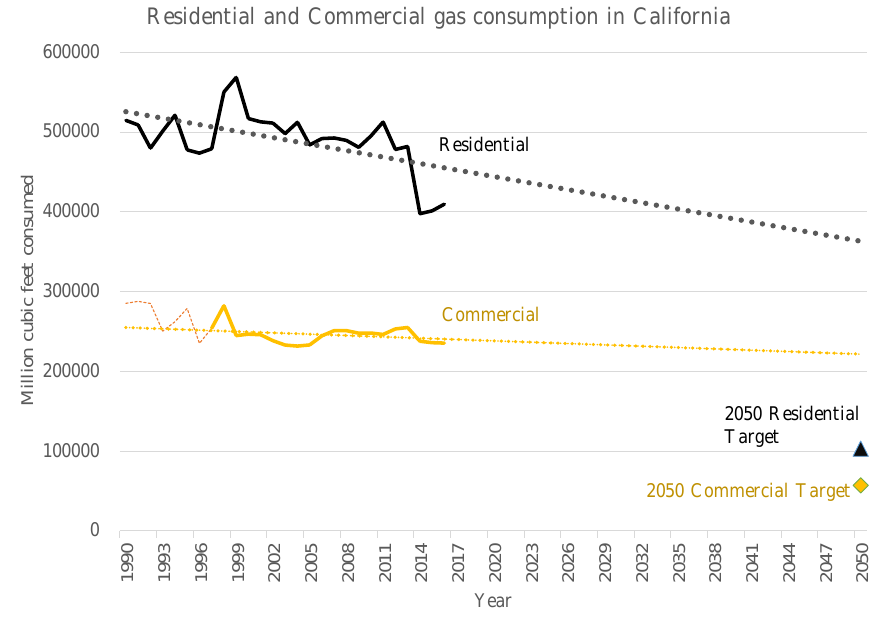
Figure 1. Historical natural gas consumption in the residential and commercial sectors in California. Commercial gas use includes natural gas used in vehicles through 1996, so the commercial trendline is based on post-1996 data [10].